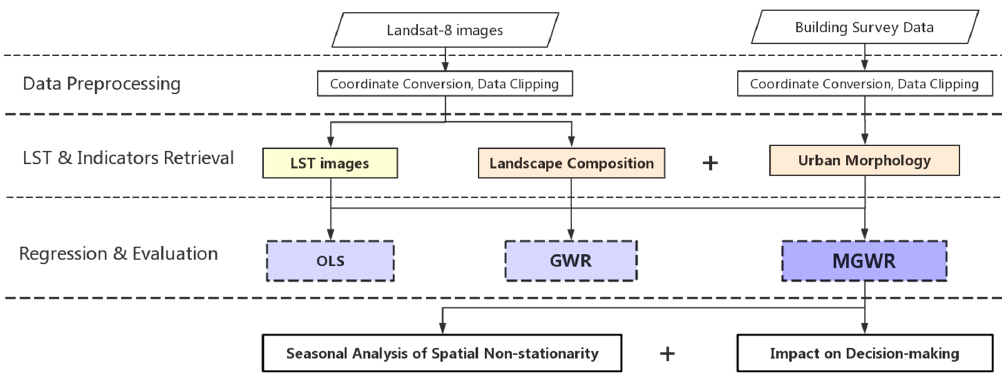
Figure 2. The methodological framework used in this study.